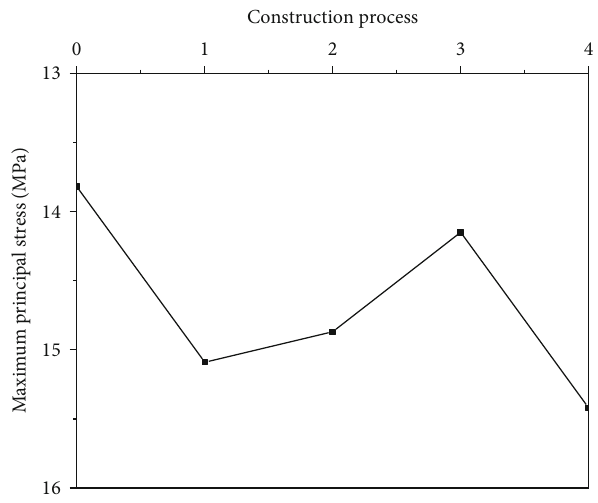
Figure 9: Maximum shear stress – construction